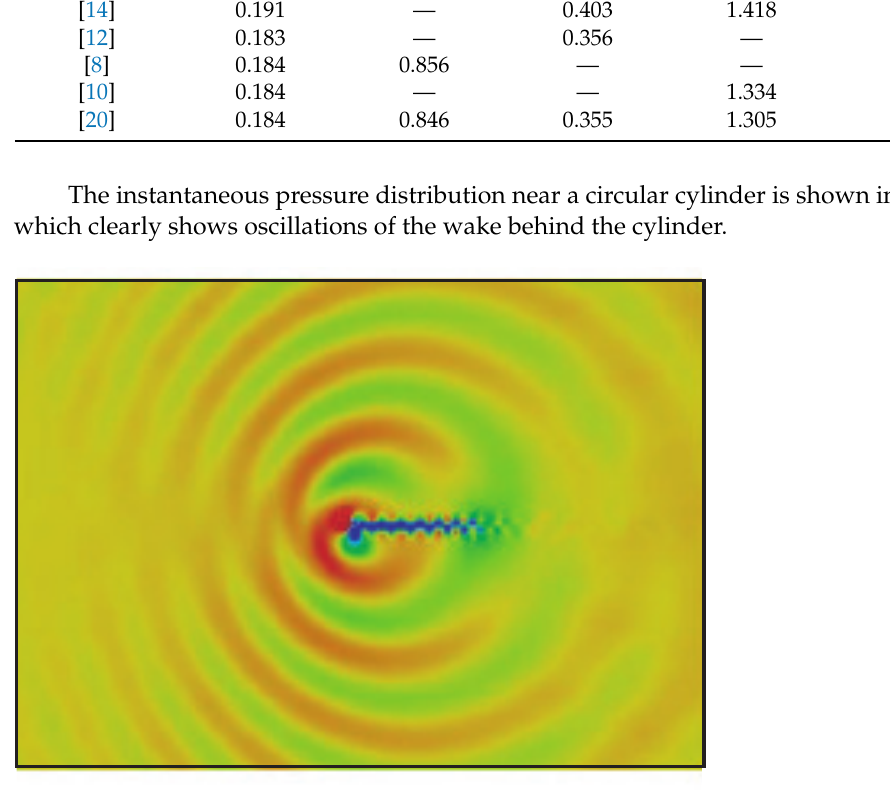
Figure 6. Instantaneous pressure distribution around a cylinder for Re = 150.